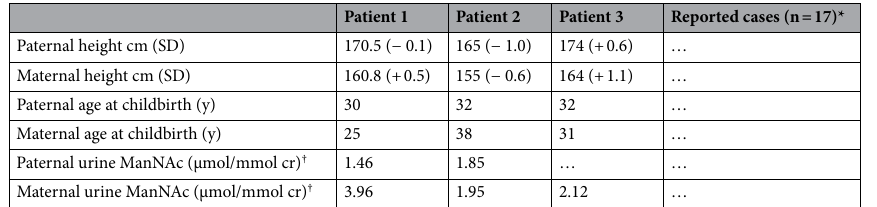
origin and a c.133−12T>A variant of paternal origin in patient 3 (reference mRNA: NM_018946.4) (Fig. 2A). These variants were confirmed by Sanger direct sequencing in patients 1–3 and their parents and by sequencing of subcloned wildtype and variant alleles in patient 1 (Fig. 2B–D). The c.979_981dup:p.(Ile327dup) variant was previously reported in two siblings with NANS-CDG 1 , whereas the remaining variants were novel. While several rare (minor allele frequencies of ≤ 0.01) variants were also revealed in other genes of patients 1–3, the overall assessment based on in silico pathogenicity predictions and phenotypic information documented in OMIM appeared to argue against their relevance to clinical findings in patients 1–3 (Supplementary Tables 1–3). Thus, we assessed the NANS variants using the ACMG guideline 9 . In patient 1, the p.(Arg69Serfs*57) vari- ant was evaluated as likely pathogenic, because it was positive for PVS1 (a null variant) and PM2 (absent from controls). The p.(Ile327dup) variant was also assessed as likely pathogenic, because it was positive for PM2 (extremely low frequency in a recessive disorder), PM3 (detected in trans with a null variant for a recessive disorder), PM4 (protein length changes in a nonrepeat region), and PP5 (a previously reported variant without functional evidence). In patient 2, we performed CytoScan HD analysis, to examine homozygosity or hemizygosity for the likely pathogenic p.(Ile327dup) variant. Consequently, segmental isodisomic regions associated with normal copy number and loss of heterozygosity were identified on chromosome 9, with the centromeric portion being het- erodisomic (Fig. 2C). Since NANS was present on the isodisomic region, this showed homozygosity for the likely pathogenic variant in patient 2. In patient 3, we examined the pathogenicity of the c.133−12T>A variant (Fig. 2D). This variant created the ″ ag ″ consensus splice acceptor motif, and SpliceAI 10 predicted splice loss for the canonical splice acceptor site and splice gain for the novel splice acceptor site. Thus, this variant was predicted to produce an aberrant mRNA containing 10 intronic sequence subject to nonsense-mediate mRNA decay (NMD) 11 . To confirm this, we car- ried out reverse transcription (RT)-PCR for mRNA extracted from lymphoblastoid cell lines (LCLs) cultured for 8 h with and without NMD-inhibitor cycloheximide (CHX), using primers hybridizing to exons 1 and 2. Subsequently, Sanger sequencing was performed for subcloned mRNA, revealing the aberrant mRNA containing 10 intronic nucleotides in CHX-treated LCLs, together with wildtype mRNA. Quantitative RT-PCR was also carried out with the same primers, indicating that relative NANS mRNA quantity between CHX-untreated and CHX-treated LCLs was nearly halved in patient 3, as compared with that of a control subject. Furthermore, Sanger sequencing for the c.607T>C:p.(Tyr203His) variant using CHX-untreated and CHX-treated LCLs indicated that the paternally inherited allele with c.133−12T>A variant and the wildtype c.607T predominantly underwent NMD. Thus, the c.133−12T>A was described as r.132_133insTGT GTT GTAG:p.(Glu45Cysfs*8) and was assessed as pathogenic, because it was positive for PSV1 (functionally null variant), PM2 (see above), and PP4 (phenotype highly specific for the variant). Accordingly, the p.(Tyr203His) variant was evaluated as likely pathogenic, because it was positive for PM2 (see above), PM3 (see above), and PP4 (see above). Glycosylation studies. We examined the N -glycosylation status of transferrin and the O-glycosylation status of apolipoprotein C-III by mass spectrometry. Despite the presence of NANS variants, both glycosylation patterns were normal in patients 1–3 (Fig. 3).